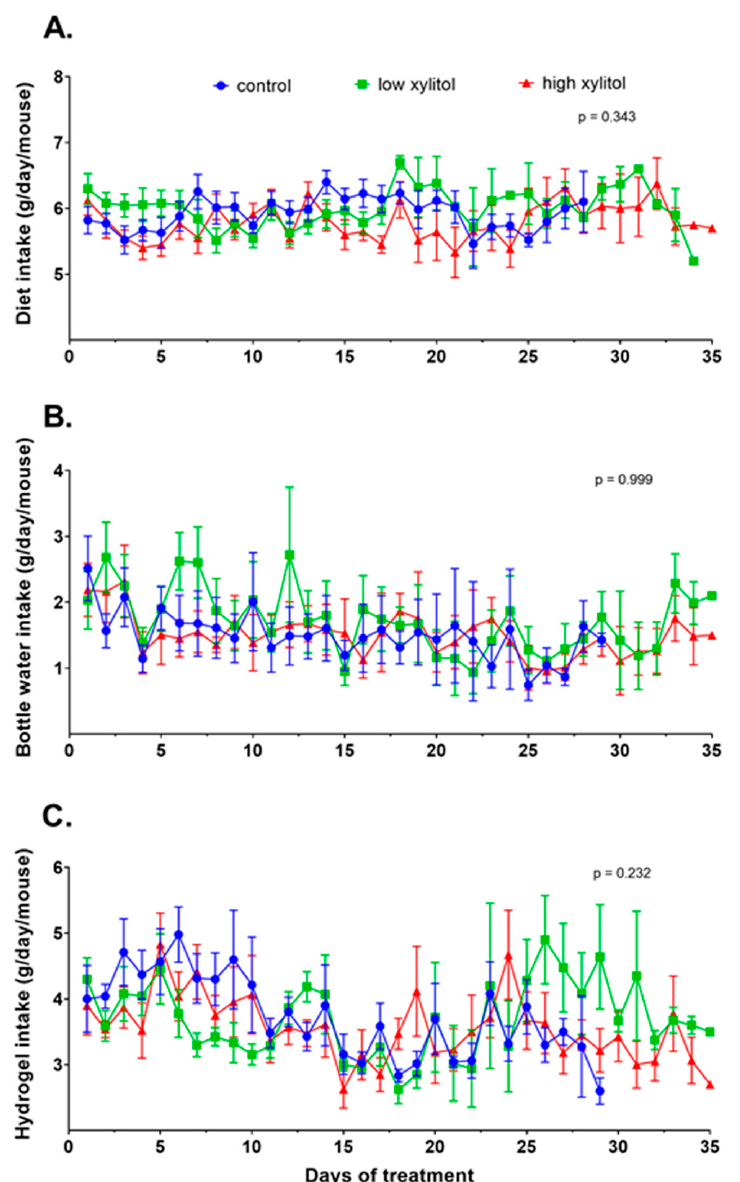
Figure 4. Food and water consumption. ( A ) Average daily diet intake, ( B ) average daily water intake, and ( C ) average daily hydrogel intake of CAL-27 xenograft mice given the glucose solution (control), low-xylitol solution (experimental group 1), and high-xylitol solution (experimental group 2). Results are shown as mean ± SEM. p -values were obtained from two-way ANOVA.